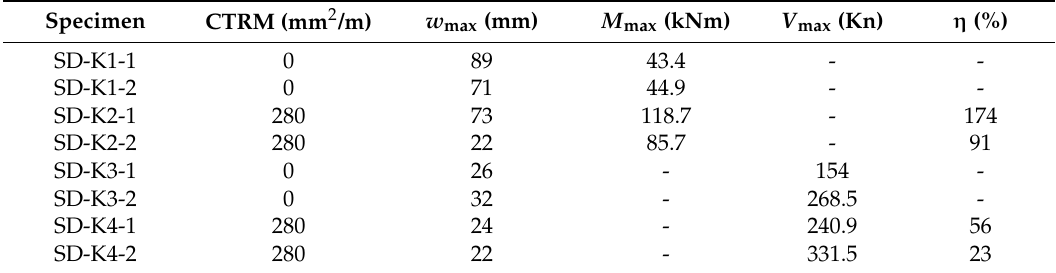
Figure 6. ( a ) Load-deflection-curve of shear tests; and ( b ) the load deflection curve of the bending tests. Table 2. Maximum bending/shear capacity M max / V max , maximum deflection w max , and strengthening degree η .